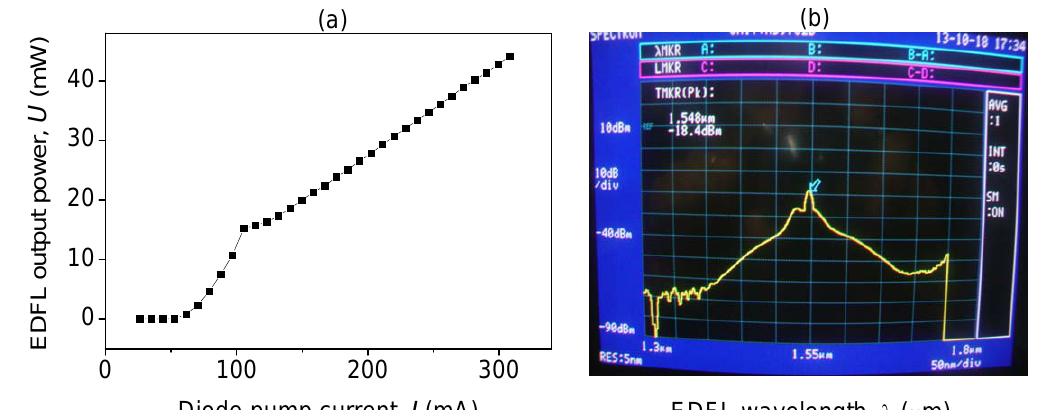
Figure 3. ( a ) EDFL output power versus diode pump current and ( b ) the EDFL optical